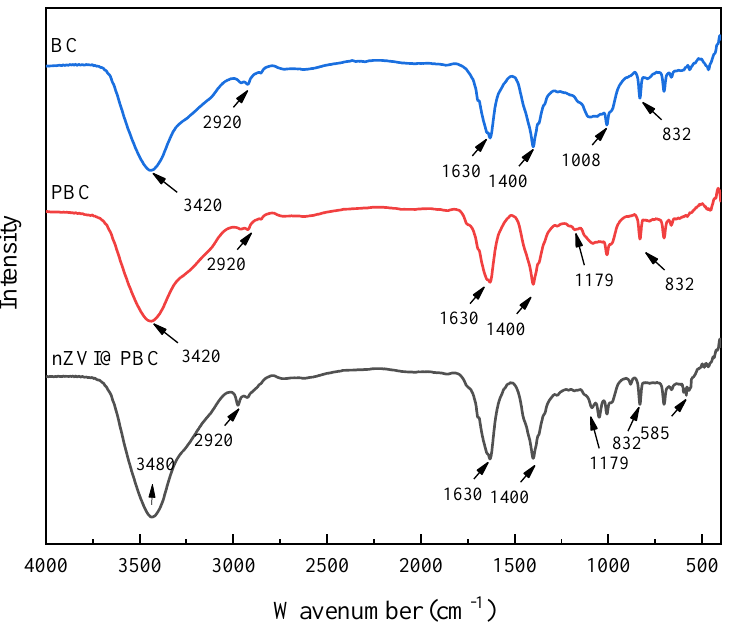
Figure 2. FT − IR spectra of BC, PBC, and Figure 2. FT−IR spectra of BC, PBC, and nZVI@PBC.